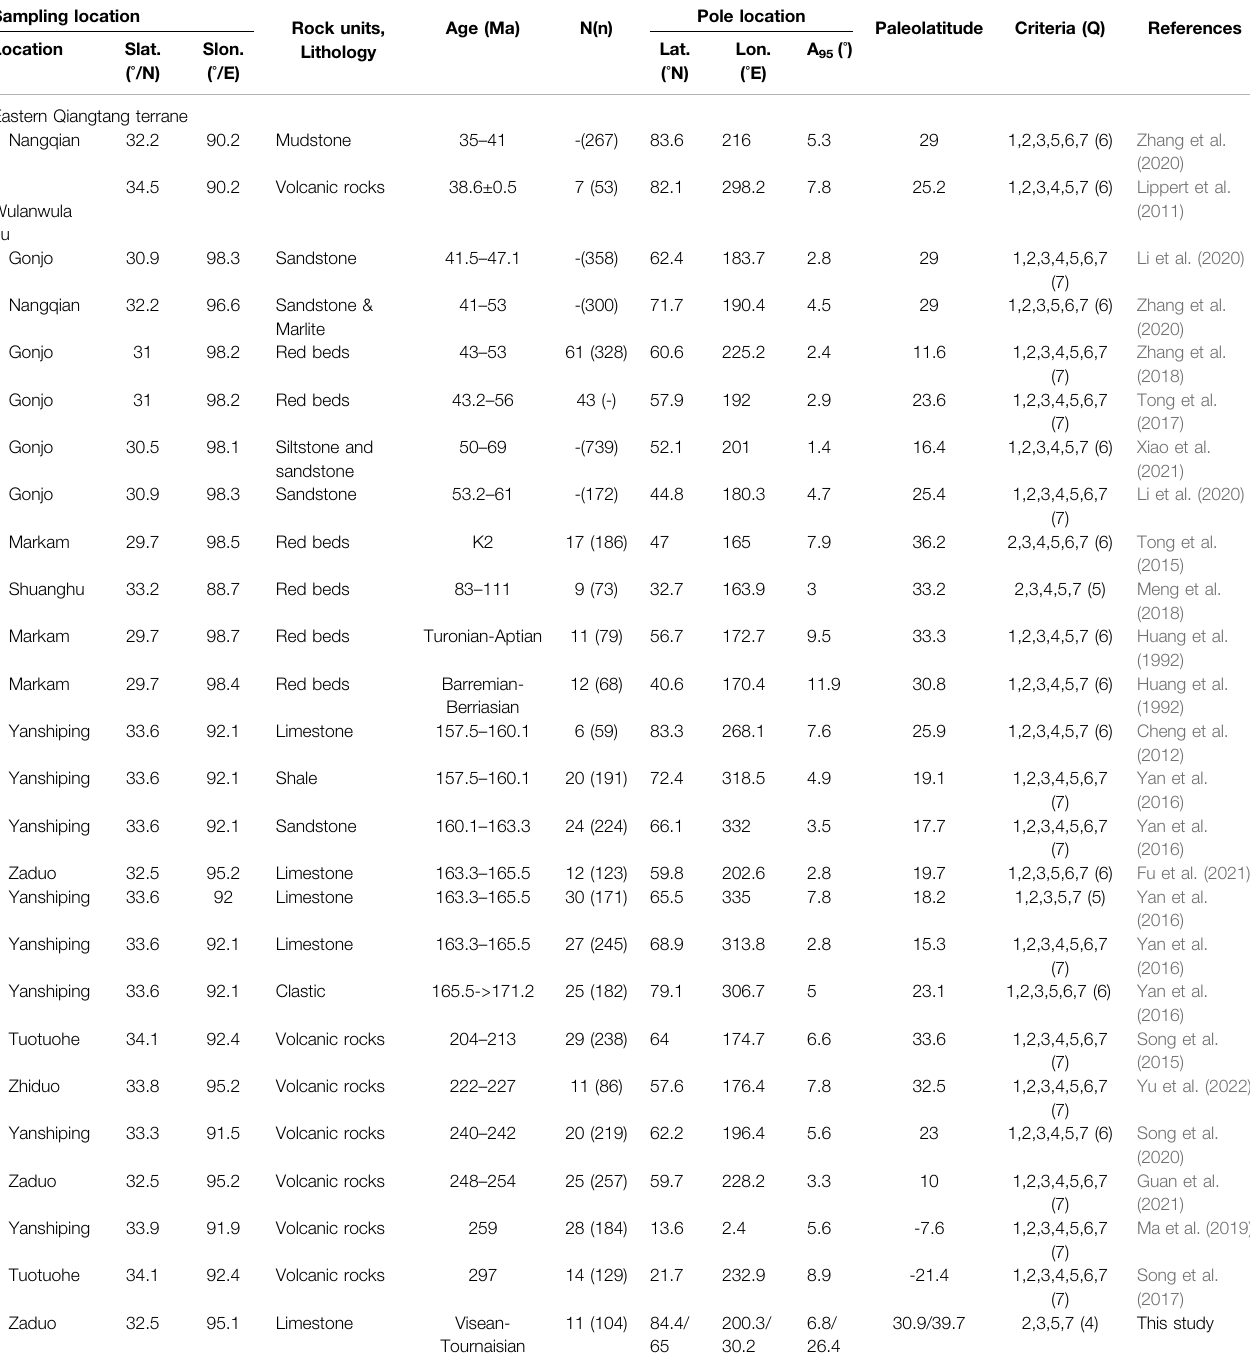
TABLE 2 | Paleomagnetic poles for the eastern Qiangtang terrane. Sampling location